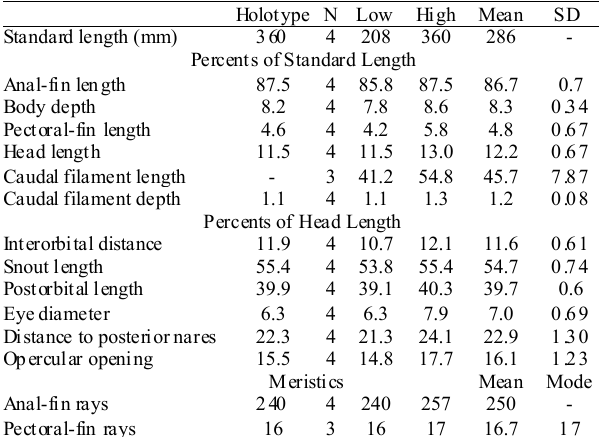
Table 1. Morphometrics and meristics of types of Iracema caiana . SD= standard deviation, and N= number of